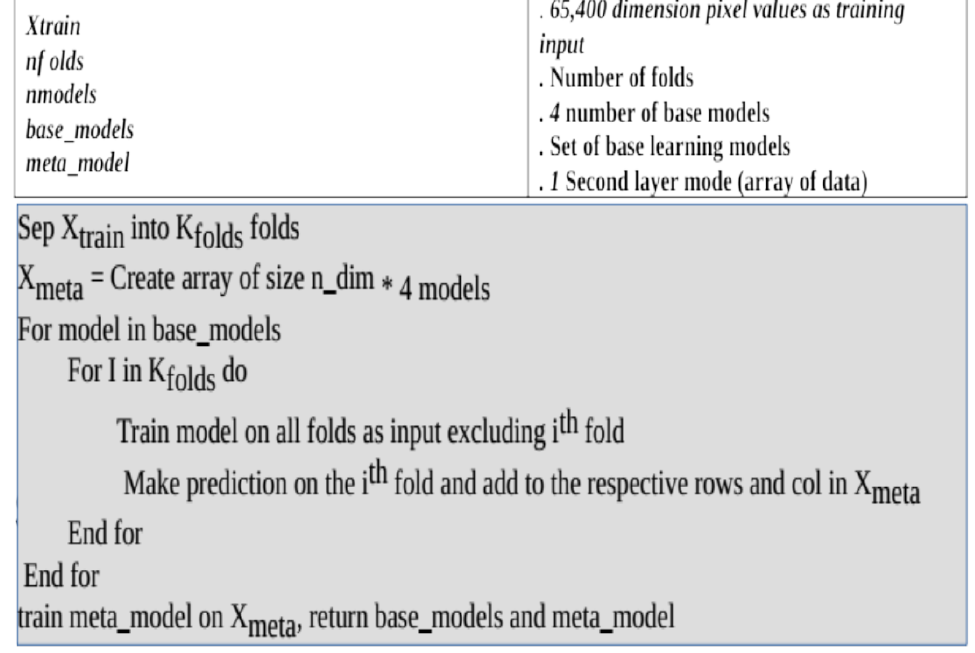
Figure 2. Stacked based ensemble learning